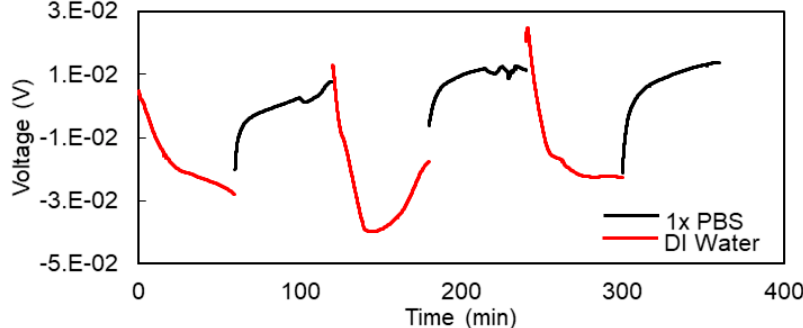
Figure 12. Potential generated across the hydrogel sensor as a function of time in response to 1× PBS and DI water.